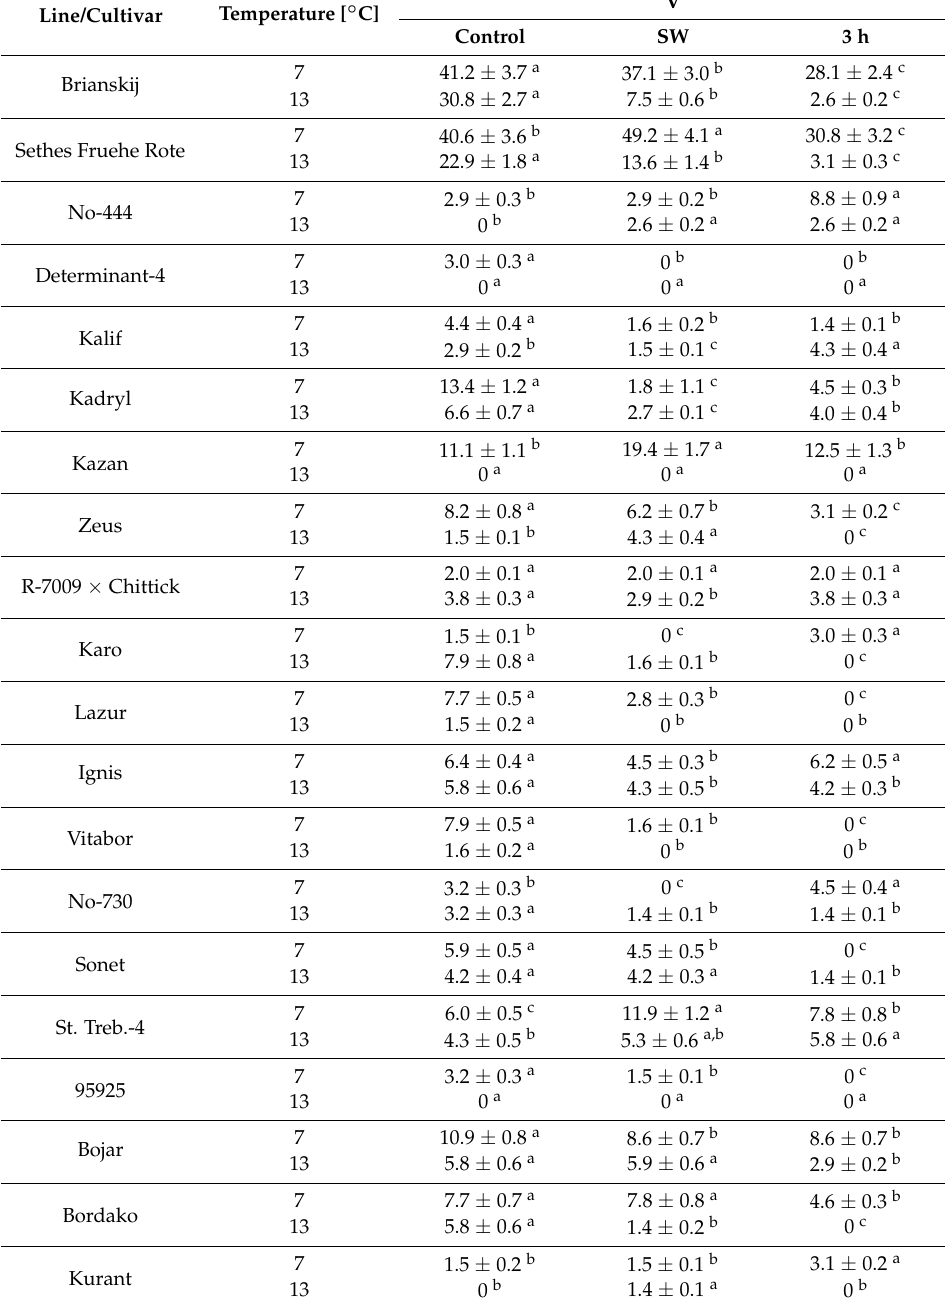
Values represent means ( n = 5) ± SE. Different superscript letters (a, b, c, ...) in the rows for each temperature indicate significant differences between means (Duncan’s multiple range test; p < 0.05). The most cold-sensitive lines/cultivars were Brianskij (41.2% of non-germinating seeds at 7 ◦ C) Determinant-4 (3.0%), and line 95925 (3.2%). Determinant-4 showed the highest number of